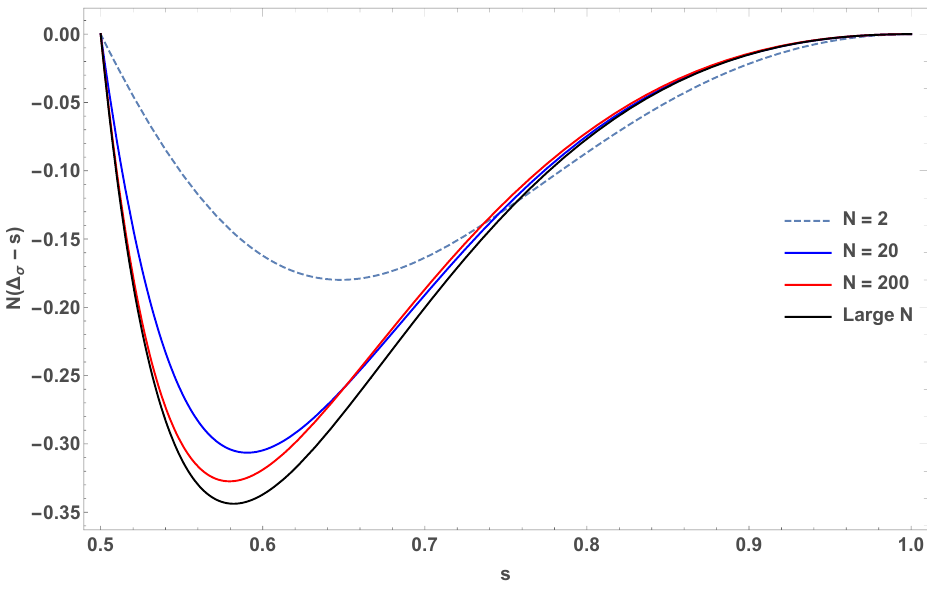
Figure 6 . Pad(cid:19)e result for (cid:1) (cid:27) for N = 2 ; 20 and 200. We plot N ((cid:1) (cid:27) (cid:0) s ) against s because that is easier to compare with the large N result. The Pad(cid:19)e result approaches large N result as we go to larger N